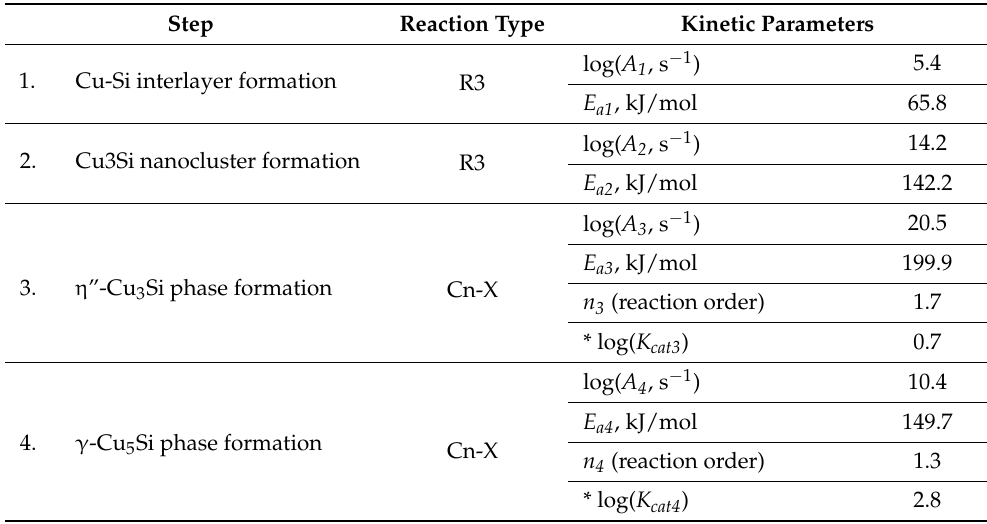
Table 7. Apparent activation energy, pre-exponential factor, reaction order, and autocatalysis rate constant of each transformation in the (Cu/a-Si) 30 multilayer films.